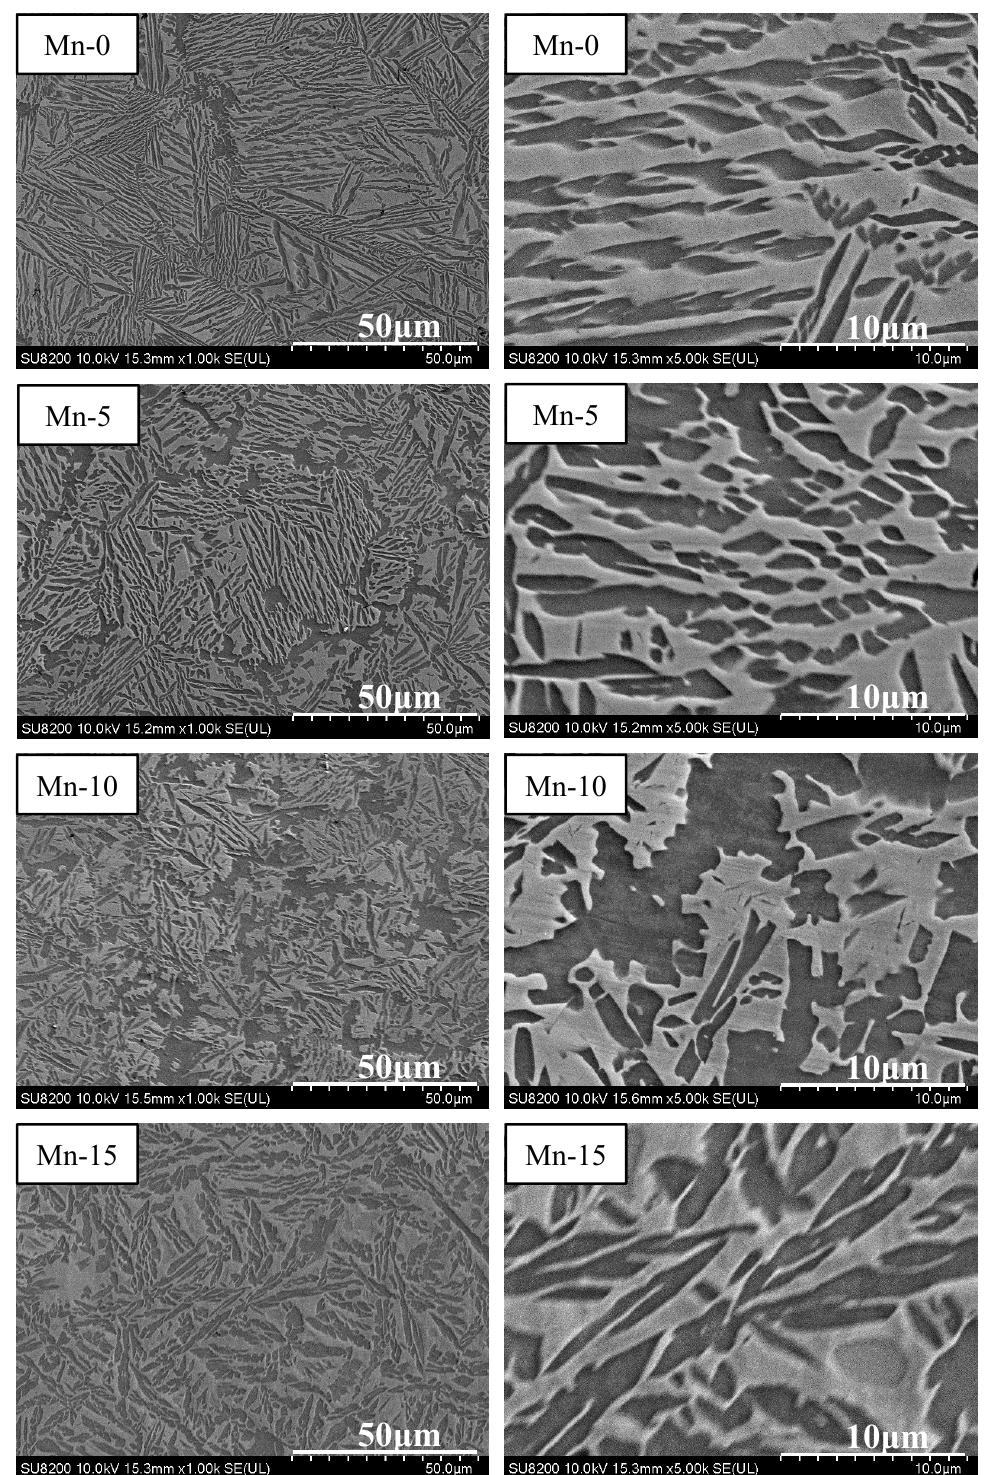
Figure 6. SEM images of the Al 50 (TiCrV) 50-x Mn x (x = 0, 5, 10, 15) alloys.